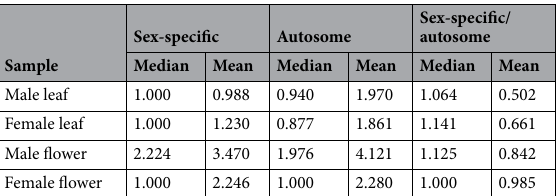
Table 1. The median and mean expression ratios of genes in sex-specific region to autosome genes in leaf and flower tissues of papaya male and female plants.